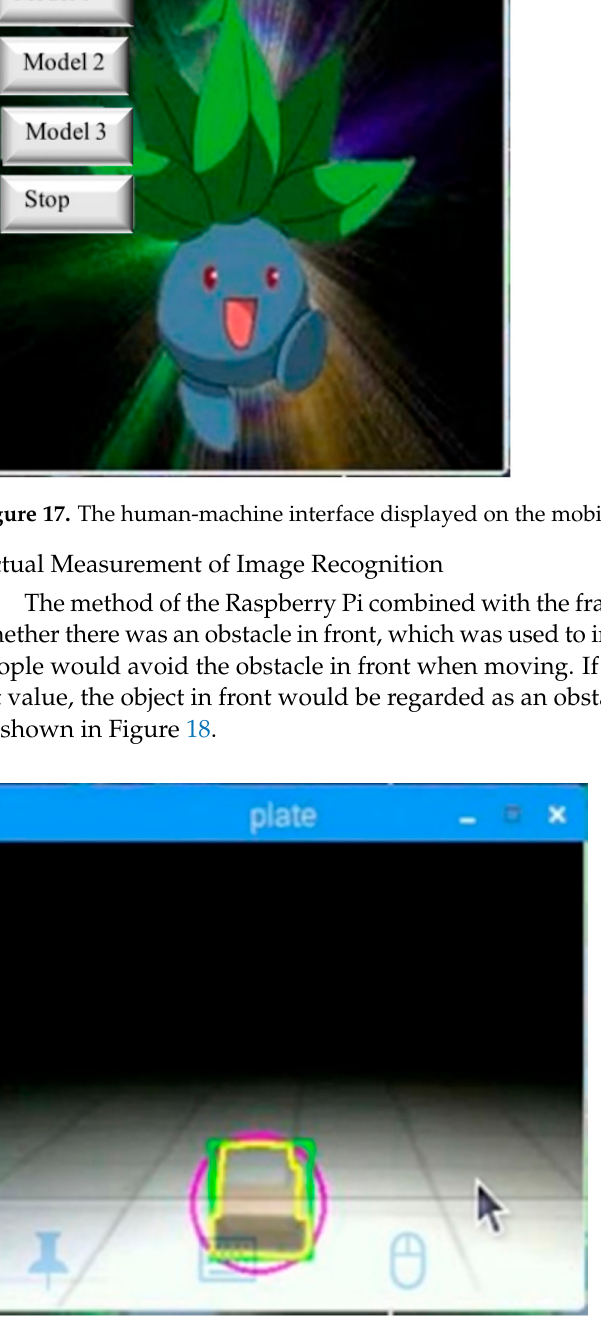
Figure 18. Obstacles ahead are marked in the window.